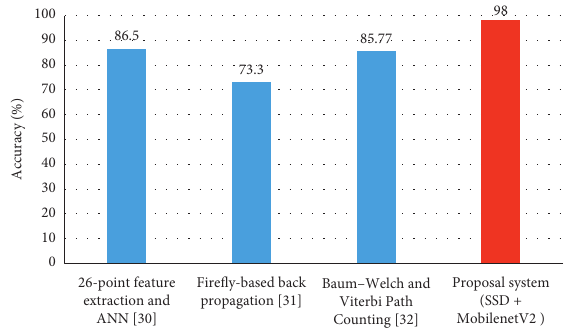
Figure 23: Result of comparing with other methods [30–32]. Table 6: Comparison of results among other methods for